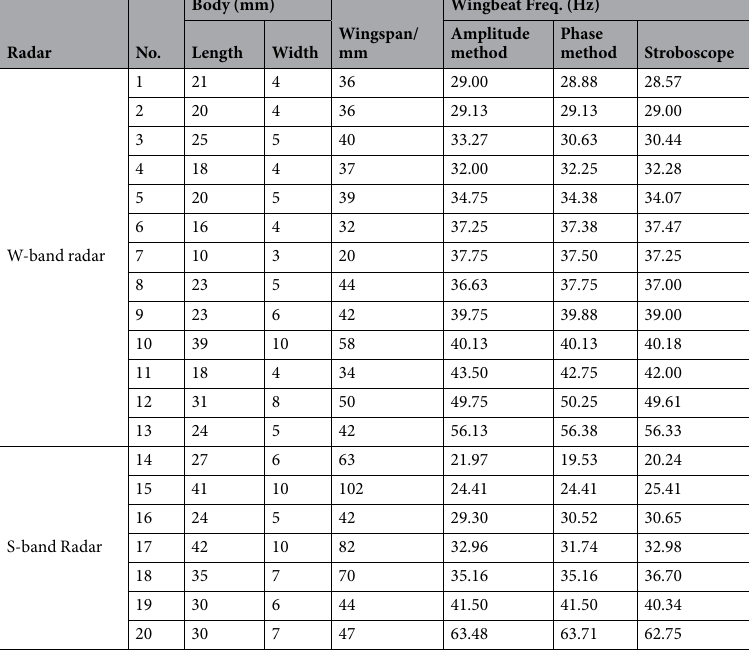
Table 2. The wingbeat frequency measurement results using W-band and S-band radars. Note: These experimental results are arranged in order of wingbeat frequency with the lowest at top. In addition, because the insect is limited and adhered to a piece of polystyrene foam in the experiment, the wing beating may be affected and the typical value of wingbeat frequency of these species cannot be used as the reference frequency for comparisons.